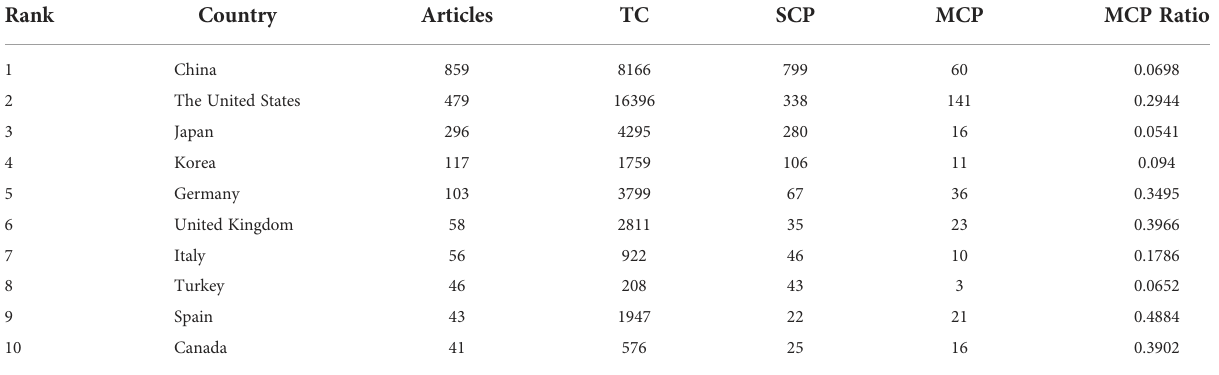
TABLE 1 The top 10 productive countries with publications of SCLC.